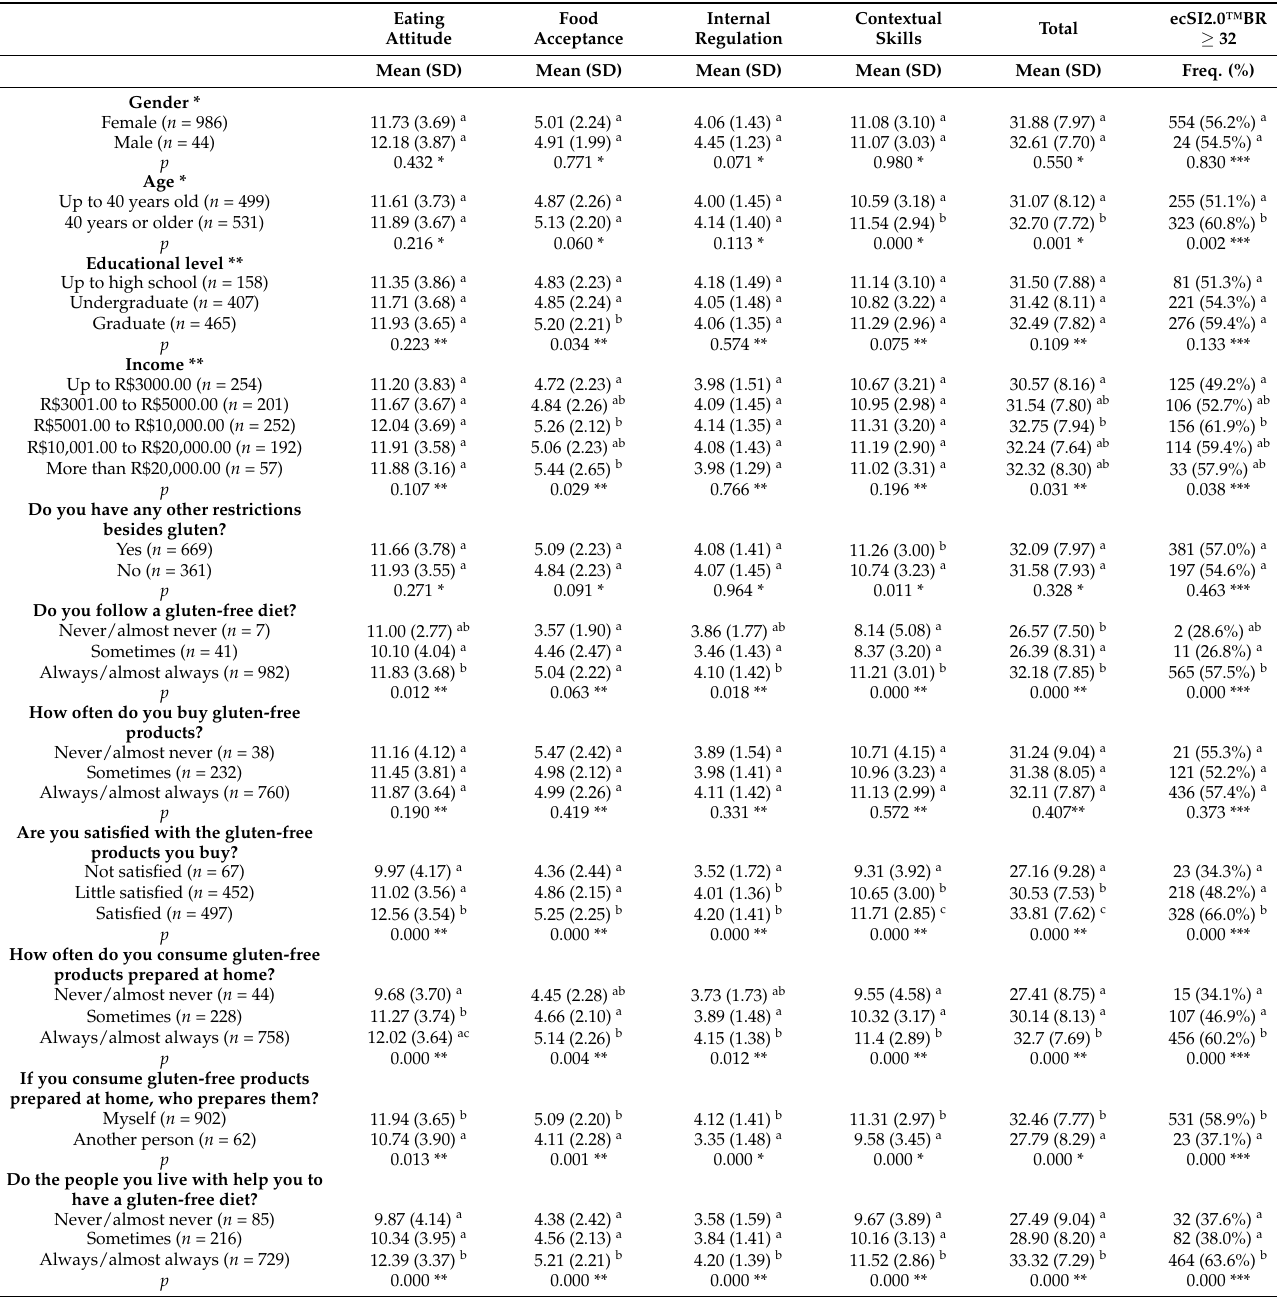
Table 1. Crossing the scores of the ecSI2.0™BR and sociodemographic data ( n =